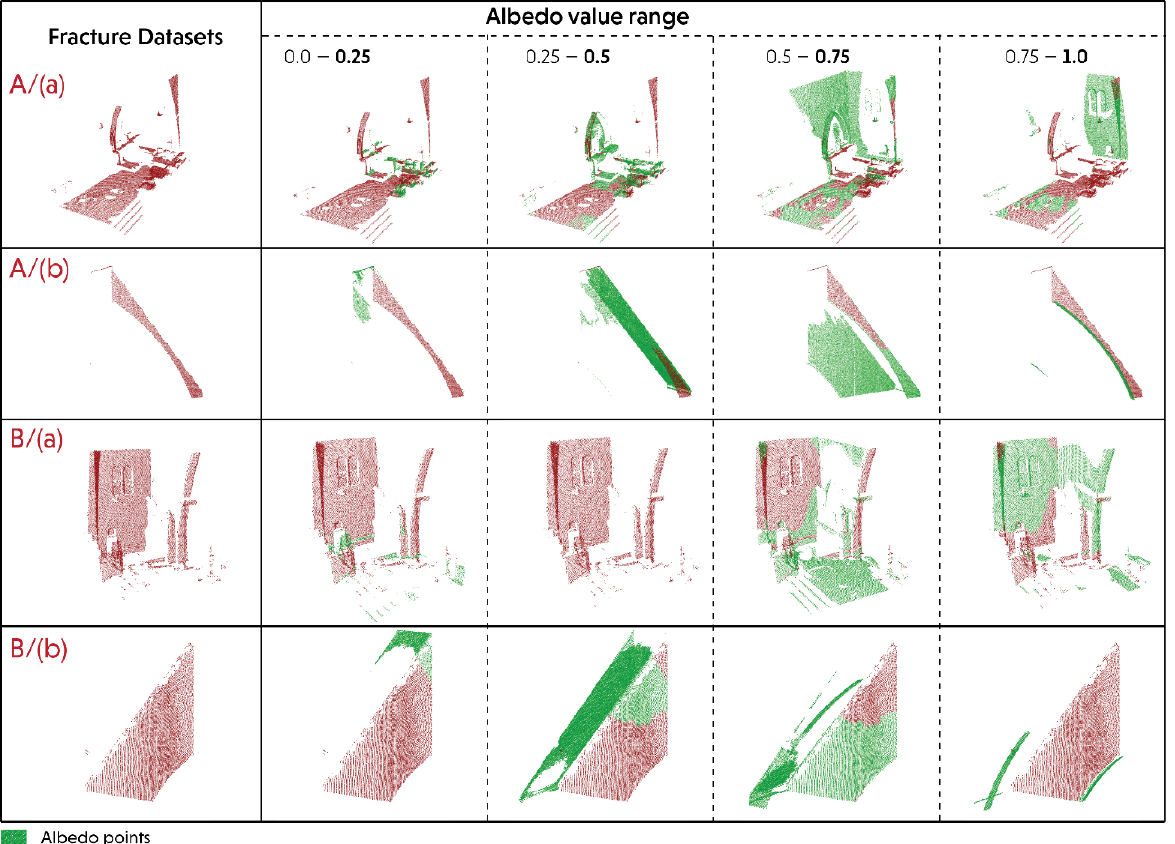
Figure 9. An integrated map between fracture datasets and albedo values. A /( a ) Fracture zone– North wall; A /( b ) Fracture zone–North roof; B /( a ) Fracture zone–South wall; B /( b ) Fracture zone– South